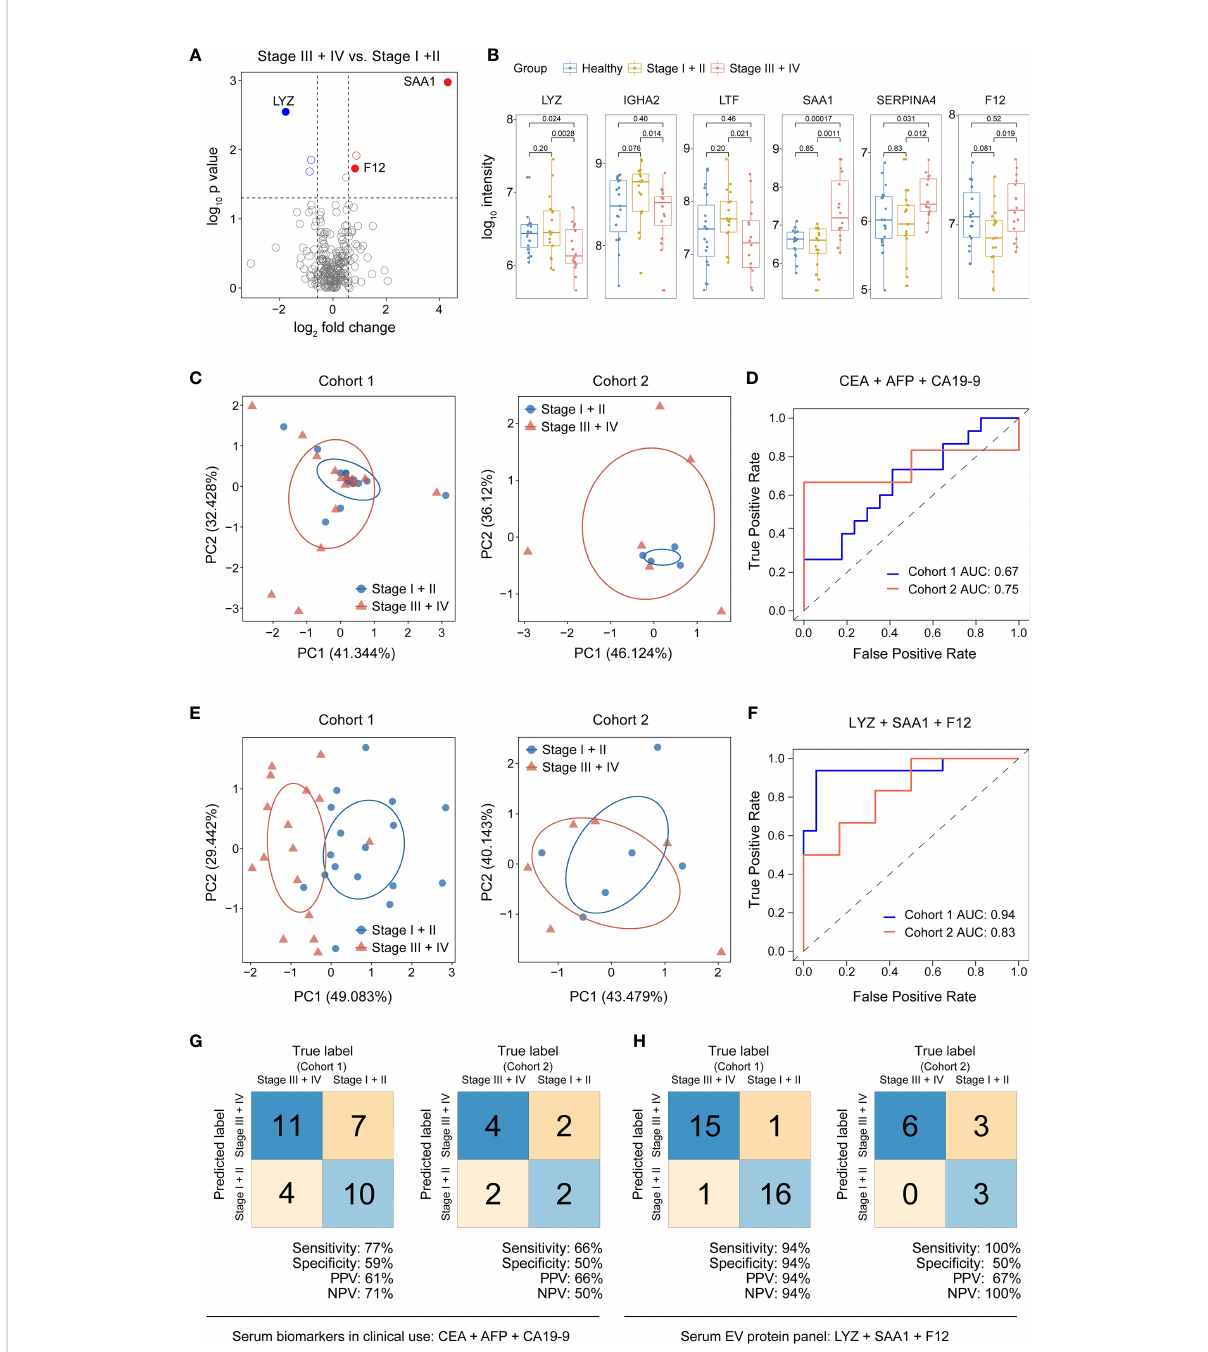
FIGURE 5 Discovery and validation of serum EV biomarkers for diagnosis of advanced stage GAC. (A) Volcano plot of signi fi cance values against log 2 -fold change between stage III + IV (N=16) and stage I + II (N=17) GAC patients from cohort 1, showing signi fi cantly changed proteins in blue or red circles. (B) Box-whisker and dot plots showing distribution of intensity values of 6 candidate proteins across three groups from cohort 1: healthy controls (N=19), stage I + II (N=17) and stage III + IV GAC patients (N=16). (C) Principal component (PC) analysis of healthy and GAC samples from cohort 1 (left) and cohort 2 (right) using clinically used serum proteins (CEA, AFP and CA19-9) for diagnosis of advanced GAC. (D) ROC curves of the 3-protein (CEA, AFP and CA19-9) logistic regression classi fi er for diagnosis of advanced GAC. (E) Principal component (PC) analysis of healthy controls and GAC samples from cohort 1 (left) and cohort 2 (right) using 3 serum EV proteins (LYZ, SAA1 and F12) for diagnosis of advanced GAC. (F) ROC curves of the 3-protein (LYZ, SAA1 and F12) logistic regression classi fi er for diagnosis of advanced GAC. (G) Classi fi cation error matrix of the 3-protein logistic regression classi fi er from D in cohort 1 and cohort 2. (H) Classi fi cation error matrix of the 3-protein logistic regression classi fi er from F in cohort 1 and cohort 2. In both (G, H) , the number of samples is noted in each